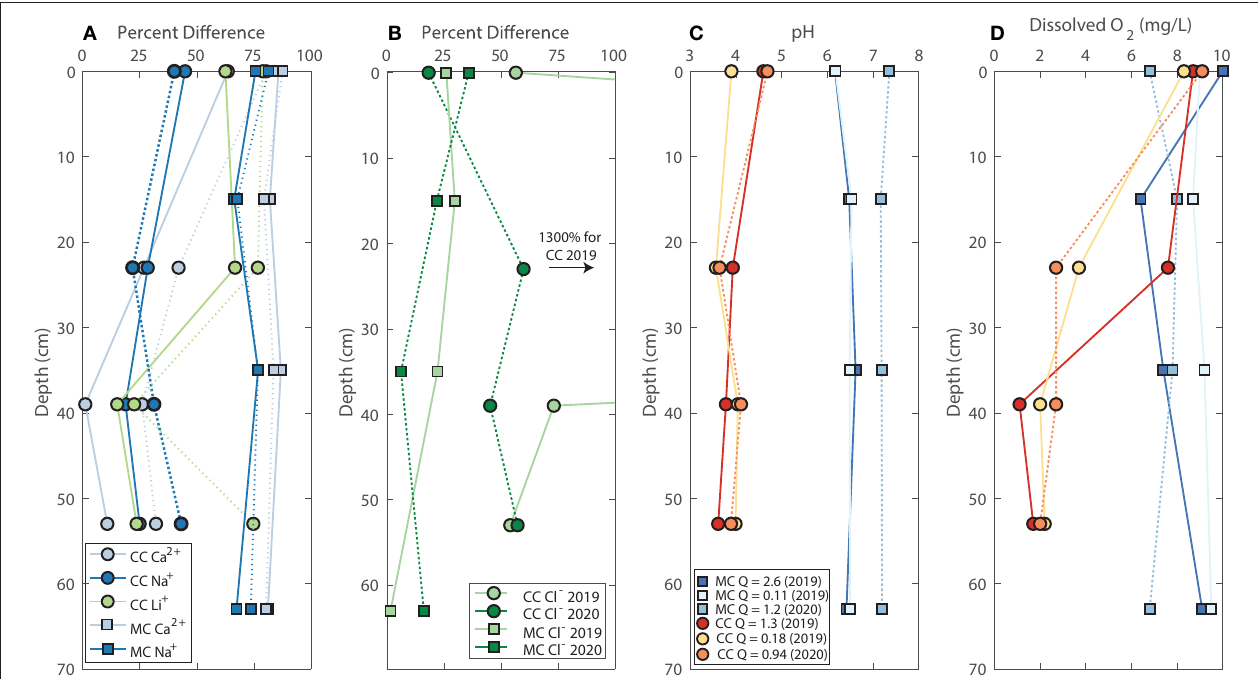
FIGURE 4 | Percent difference between high flow in 2019 and low flow in 2019 (solid lines), as well as high flow in 2020 and low flow in 2019 (dashed lines), in the dissolved concentrations of (A) Ca 2 + , Na + , and Li + , and (B) Cl − . Field measurements are included for all sampling times of (C) pH and (D) dissolved oxygen. The discharges corresponding to these sampling times are included in the legend of (C) . The data points at depth represent the mid-point of the 10-cm screened interval. The 0-cm depth represents concentrations or measurements in the